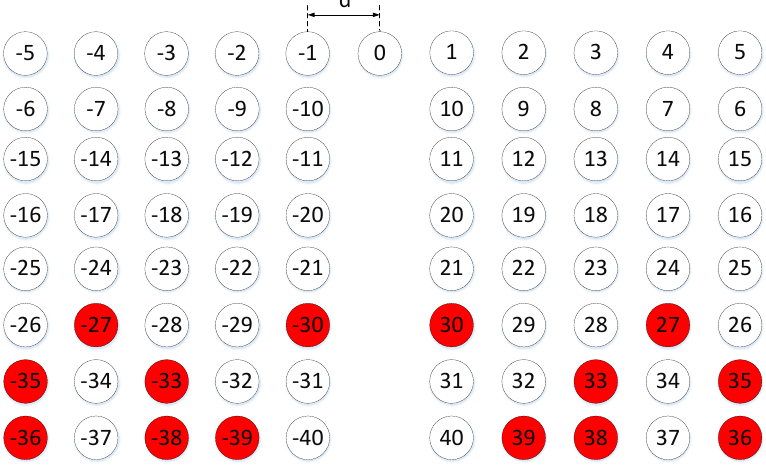
Figure 2. The distribution of the conventional DCA. Therein, the red circle represents the hole, and the white circle indicates the element of virtual ULA constructed by